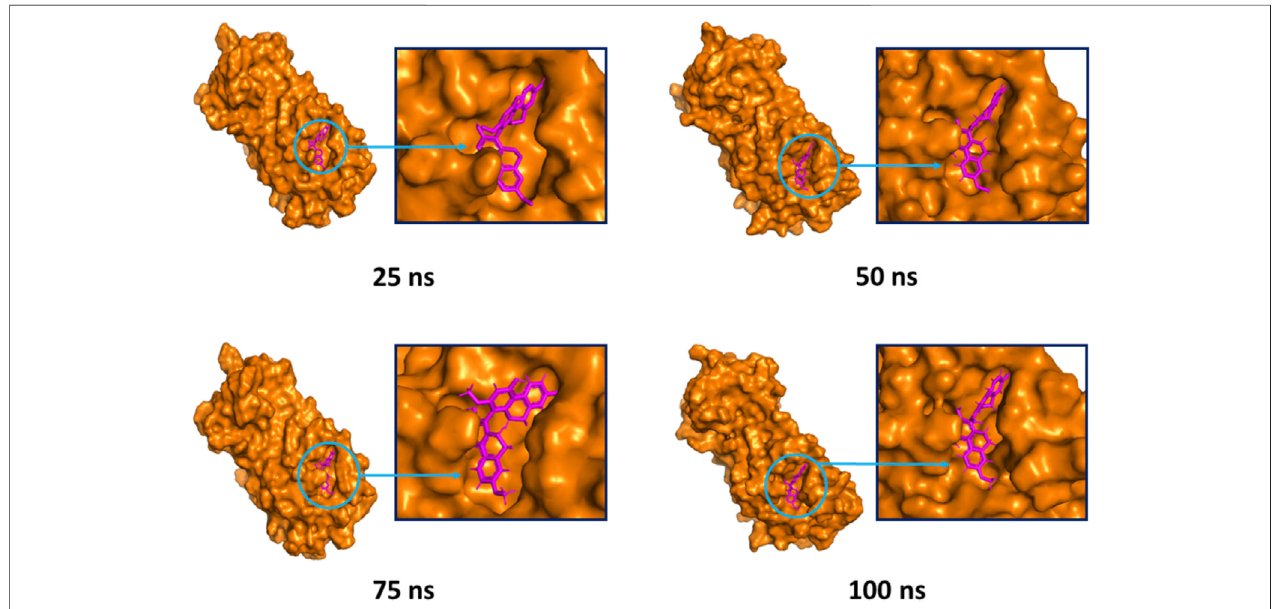
Frontiers in Bioinformatics |